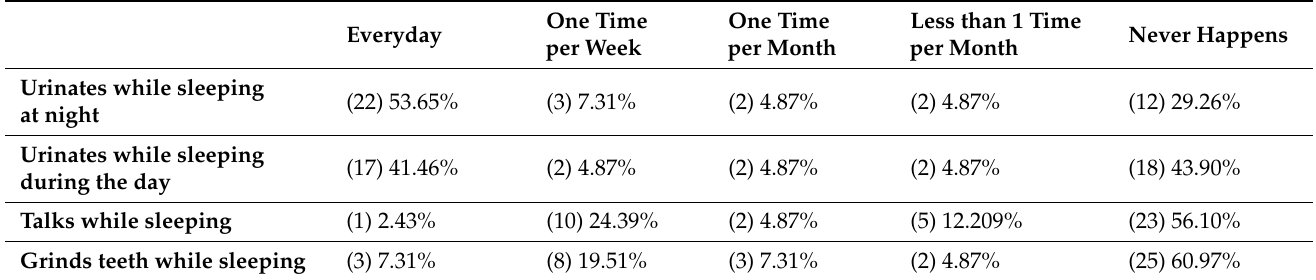
Table 3. Sleep pattern assessment and presence of sleep